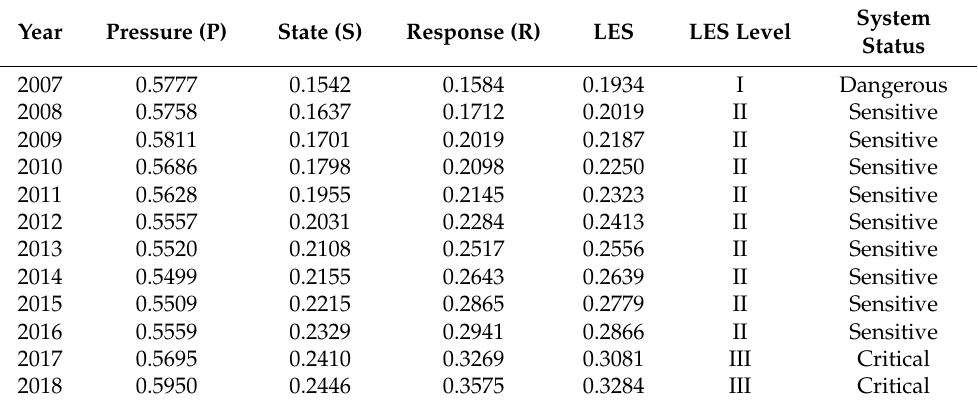
Figure 2. Changes in LES for the BTH region from 2007 to 2018. Table 3. The LES of the BTH region from 2007 to 2018.